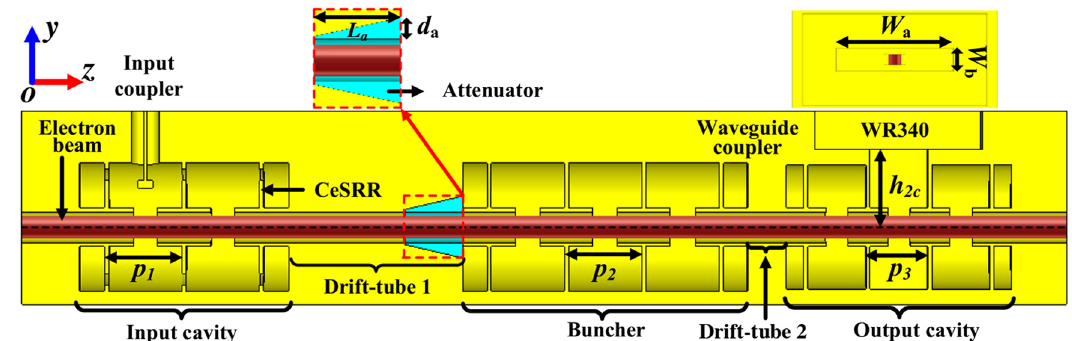
Fig. 9. Schematic of the 3-cavity MEIK in the yoz plane. The periods of the input cavity, mid-cavity (buncher), and output cavity are p 1 = 20mm, p 2 =20 mm, and p 3 =16 mm, respectively, and the parameters of the waveguide coupler are W a = 50.5mm, W b =16 mm, and h 2c =19 mm. The length of drift-tube 1 and drift-tube 2 are 55 and 20 mm, respectively, and the entire interaction length is ∼ 210 mm ( ∼ 1.72 l )